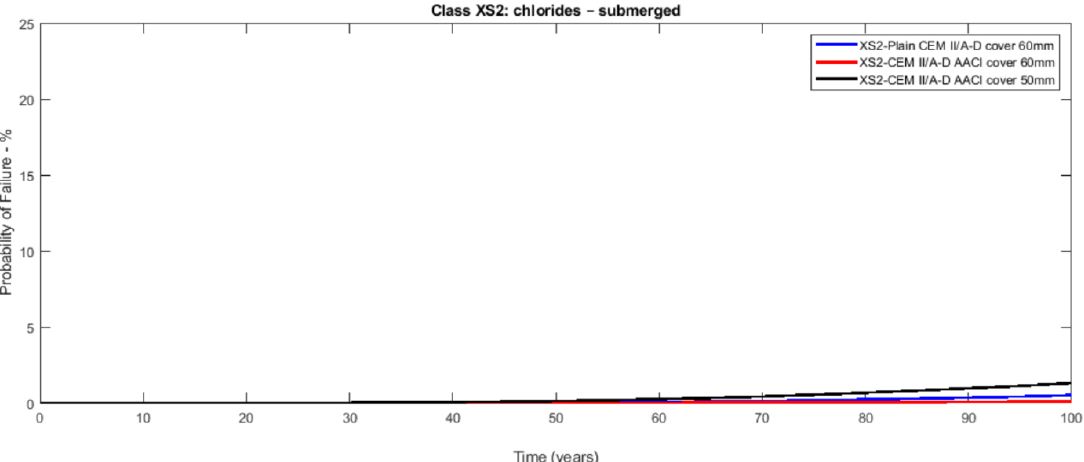
Figure 4. Probabilistic service life results of CEM II/A-D concrete — exposure class XS2 (submerged) — without and with AACI for a cover of 60 and 50 mm.